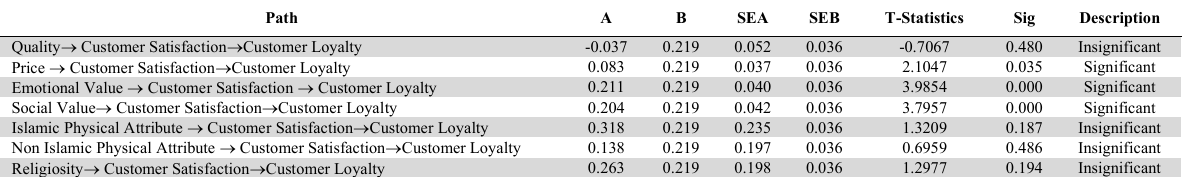
Indirect effect test